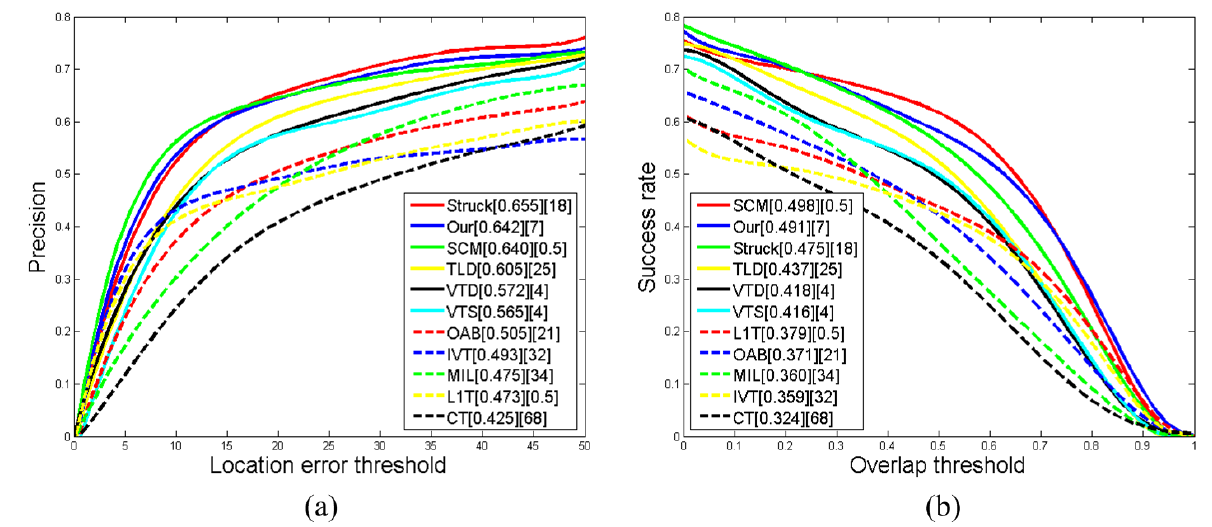
Figure 6. The performance score for each tracker is shown in the legend. ( a ) The precision plots of CLE, and the score is the precision at the threshold of 20 pixels; ( b ) the success plots of VOR, and the score is the AUC value. The second square bracket indicates the corresponding Fps of each